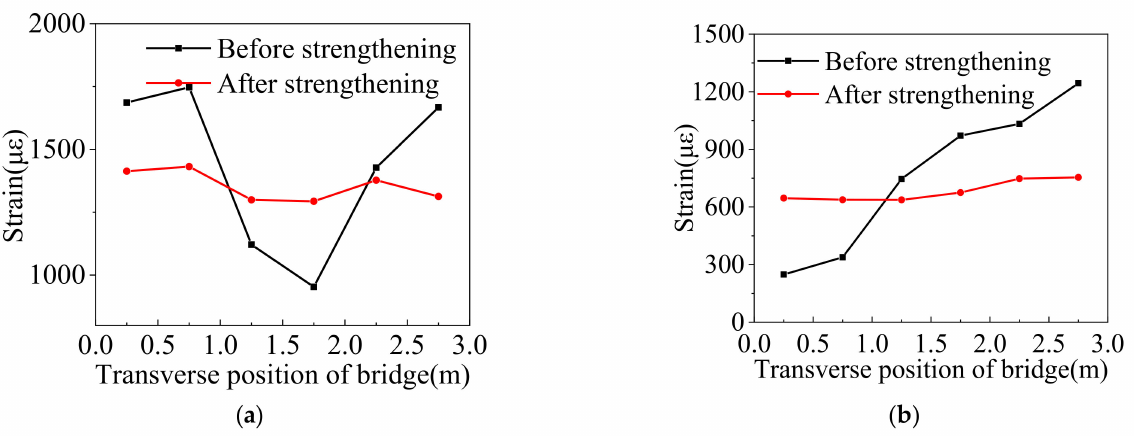
Figure 10. Concrete strains in the underside of the box girders at the mid-span. ( a ) Symmetrical loading. ( b ) Partial